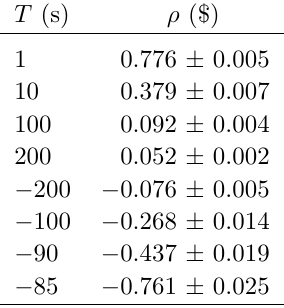
Table 2. IPEN/MB-01 benchmark model reactivities